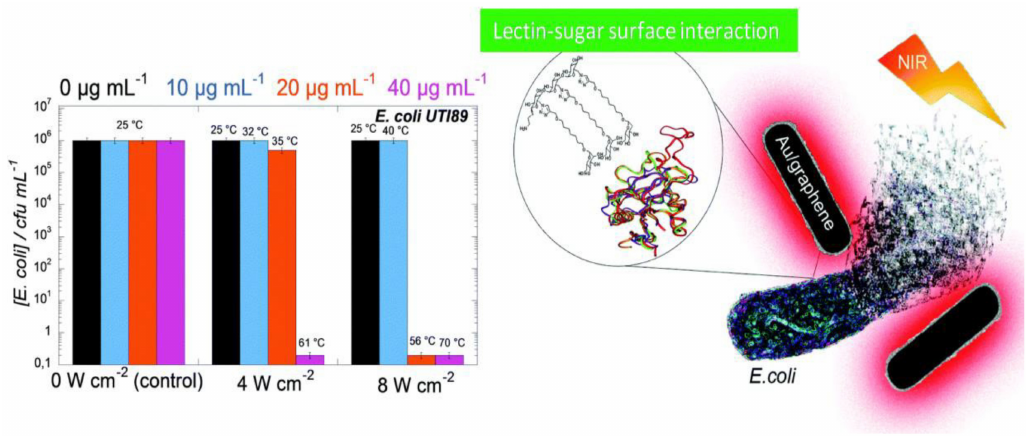
Figure 6. E. coli viability in the presence of rGO–PEG–Au NPs upon irradiation at 4 or 8 W cm − 2 for 10 min. Reproduced from Ref. [68], with permission from the Royal Society of Chemistry,